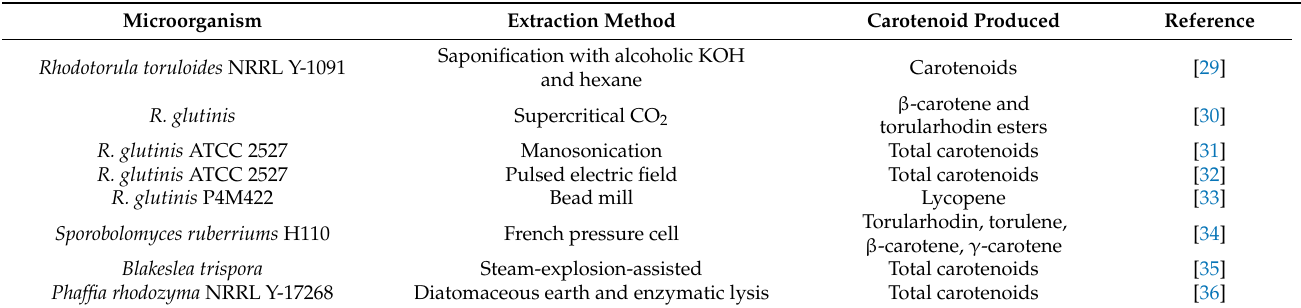
Table 2. Some recent methods for the extraction of